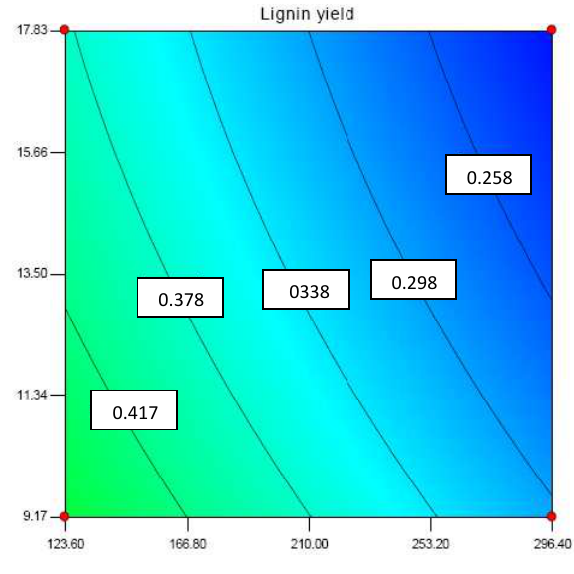
Fig. 2-C.X: time (min), Y: Pressure (bar), temperature 147 0 C